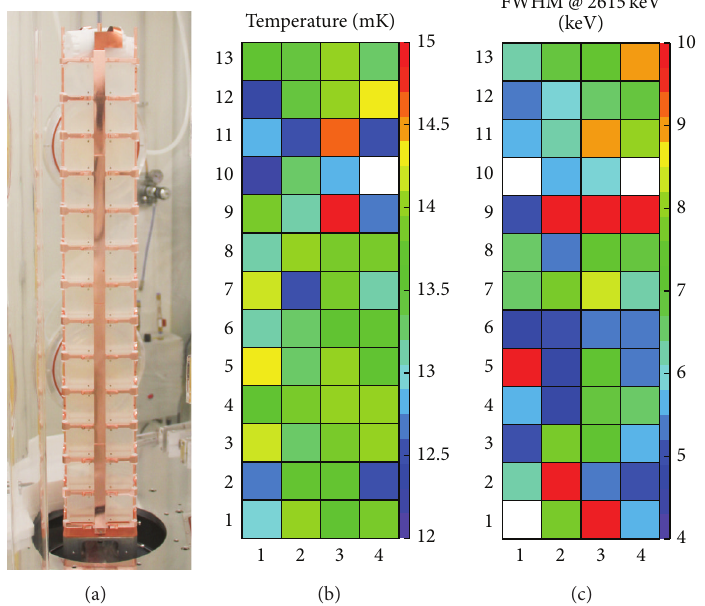
Figure 4: (a) The CUORE-0 tower inside a glove box during its assembly. (b) Base temperatures of the functioning CUORE-0 crystals, as calculated from the measured resistances of their thermistors in conjunction with 𝑅 0 and 𝑇 0 values previously determined in thermistor characterization studies (see Section 2). It should be mentioned that there is good evidence that a thermistor’s 𝑅 - 𝑇 behavior can be modified by mechanical stresses caused by its glue-spot connections to the crystal, and this effect could be responsible in part for the seemingly erratic distribution of detector temperatures. (c) Energy resolution (FWHM) of each detector channel, determined from calibrations performed regularly during March–September 2013. The mean energy resolution in the calibration data is 6.8 keV, and the median is 6.0 keV.